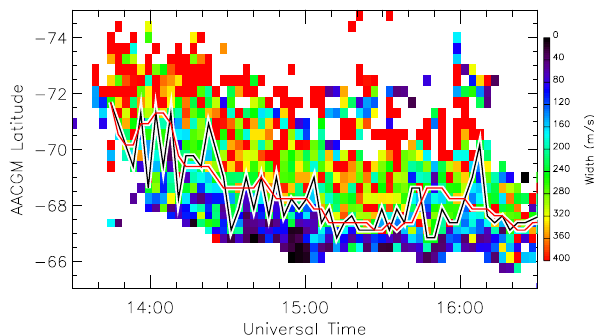
Fig. 13. An example of the determination of the spectral width boundary using both algorithm 2 (black solid line) and algorithm 3 (red solid line). The spectral width data is taken from beam 8 of the Halley SuperDARN radar on 20 August